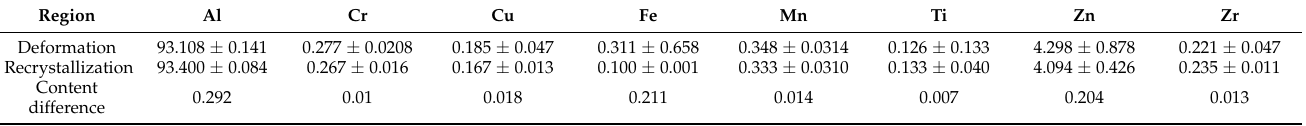
Table 8. EDS content differences between recrystallization and deformation microstructures